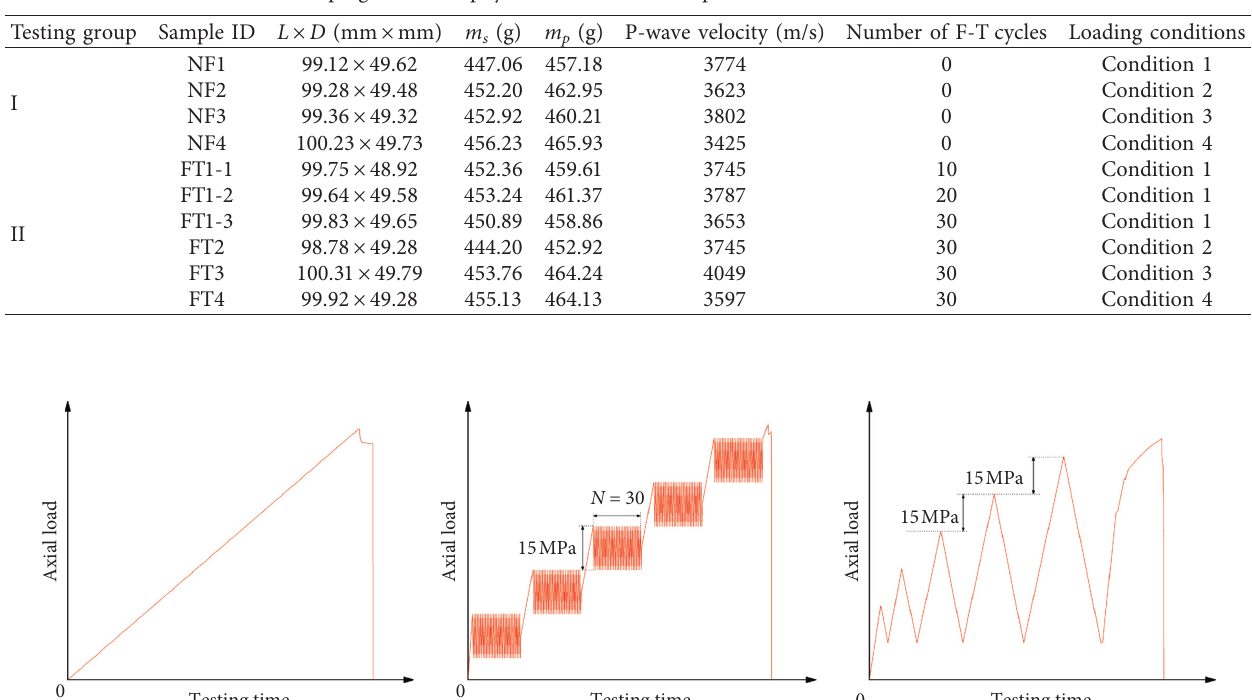
Table 1: Grouping and basic physical and mechanical parameters of the tuff used in this test.